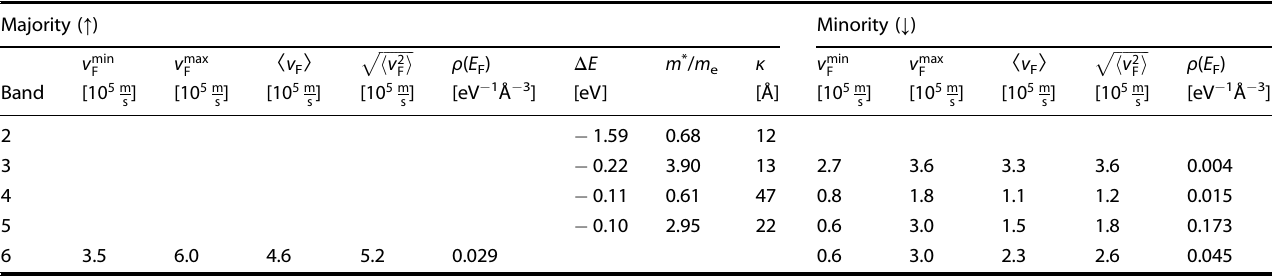
Table 1. Minimum, maximum, average, and root mean square of the Fermi velocities v F for the majority and minority Fermi surfaces in bulk Ni. Majority ( ↑ )